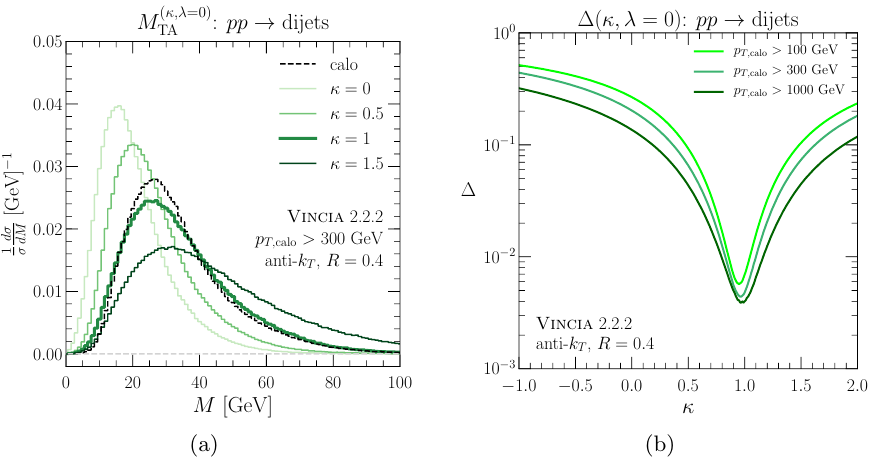
Figure 3 . Same as (cid:12)gure 2 but (a) with GTAM parameters (cid:20) = (cid:1)( (cid:20); (cid:21) = 0) as a function of (cid:20) .